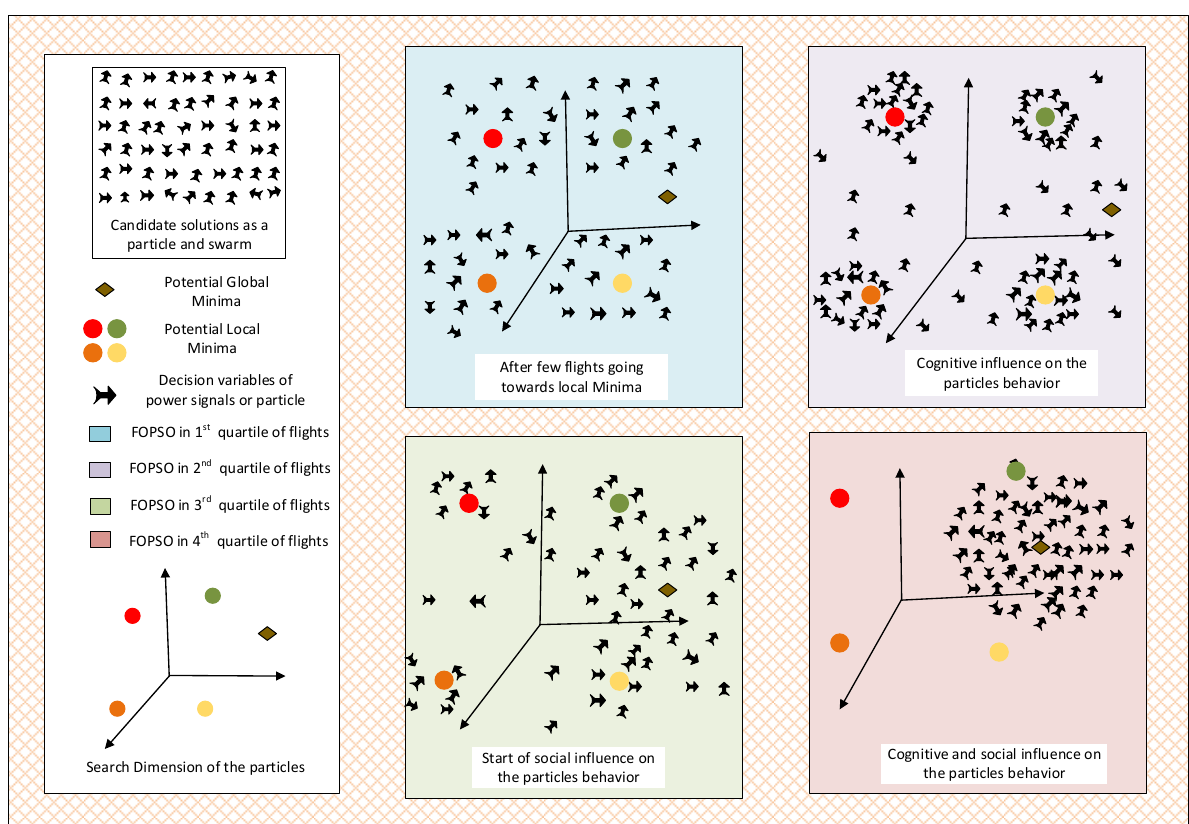
Figure 3. Generic diagram for working principle of FOPSO.